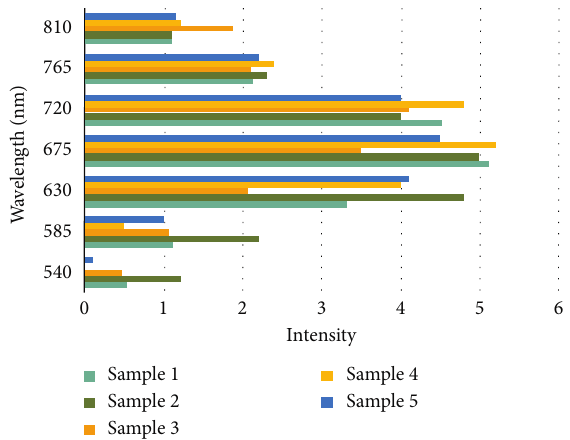
Figure 3: Laser fluorescence of samples 1–5 paper.